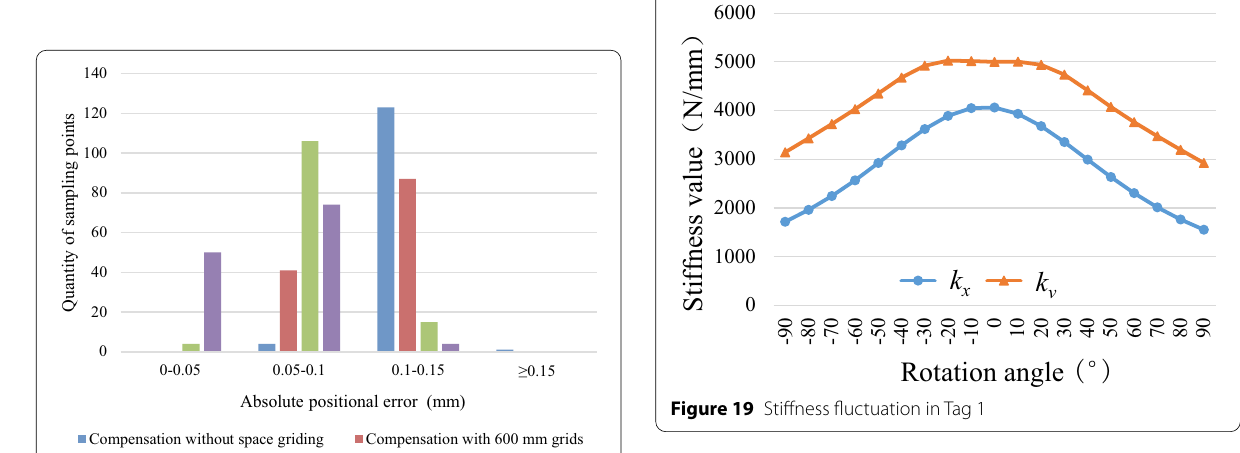
Workblank Toolinng